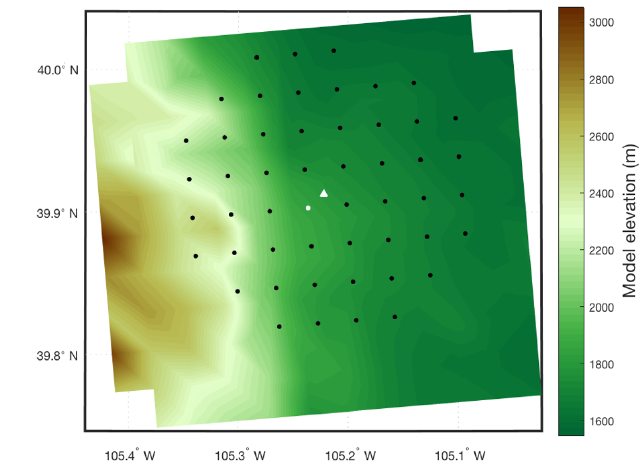
Figure 1. Model elevation (color contour) surrounding the M5 tower (white triangle). The 50 closest model grid points (dots) are overlaid. The white dot shows the closest model grid point to the M5